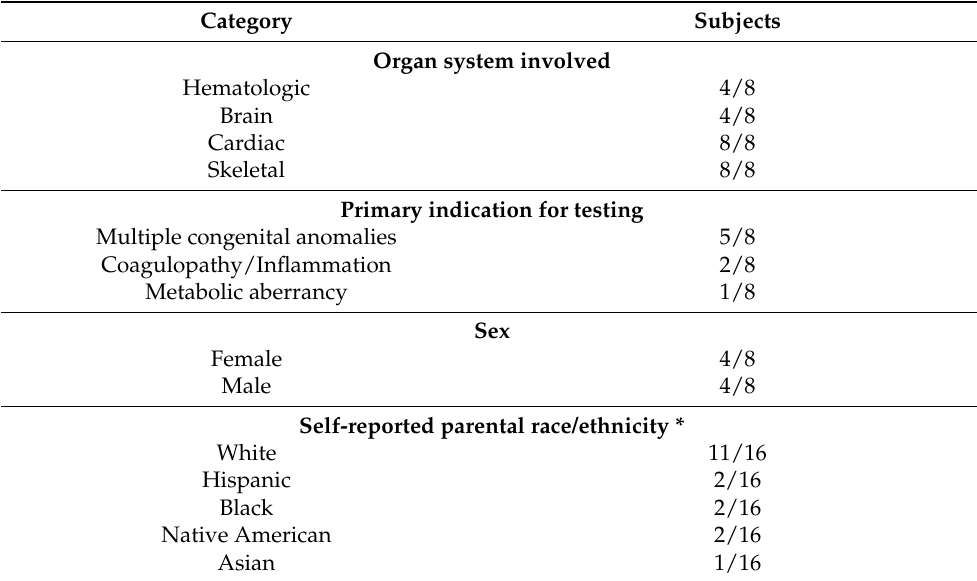
Table 1. Demographics and testing indications of enrolled